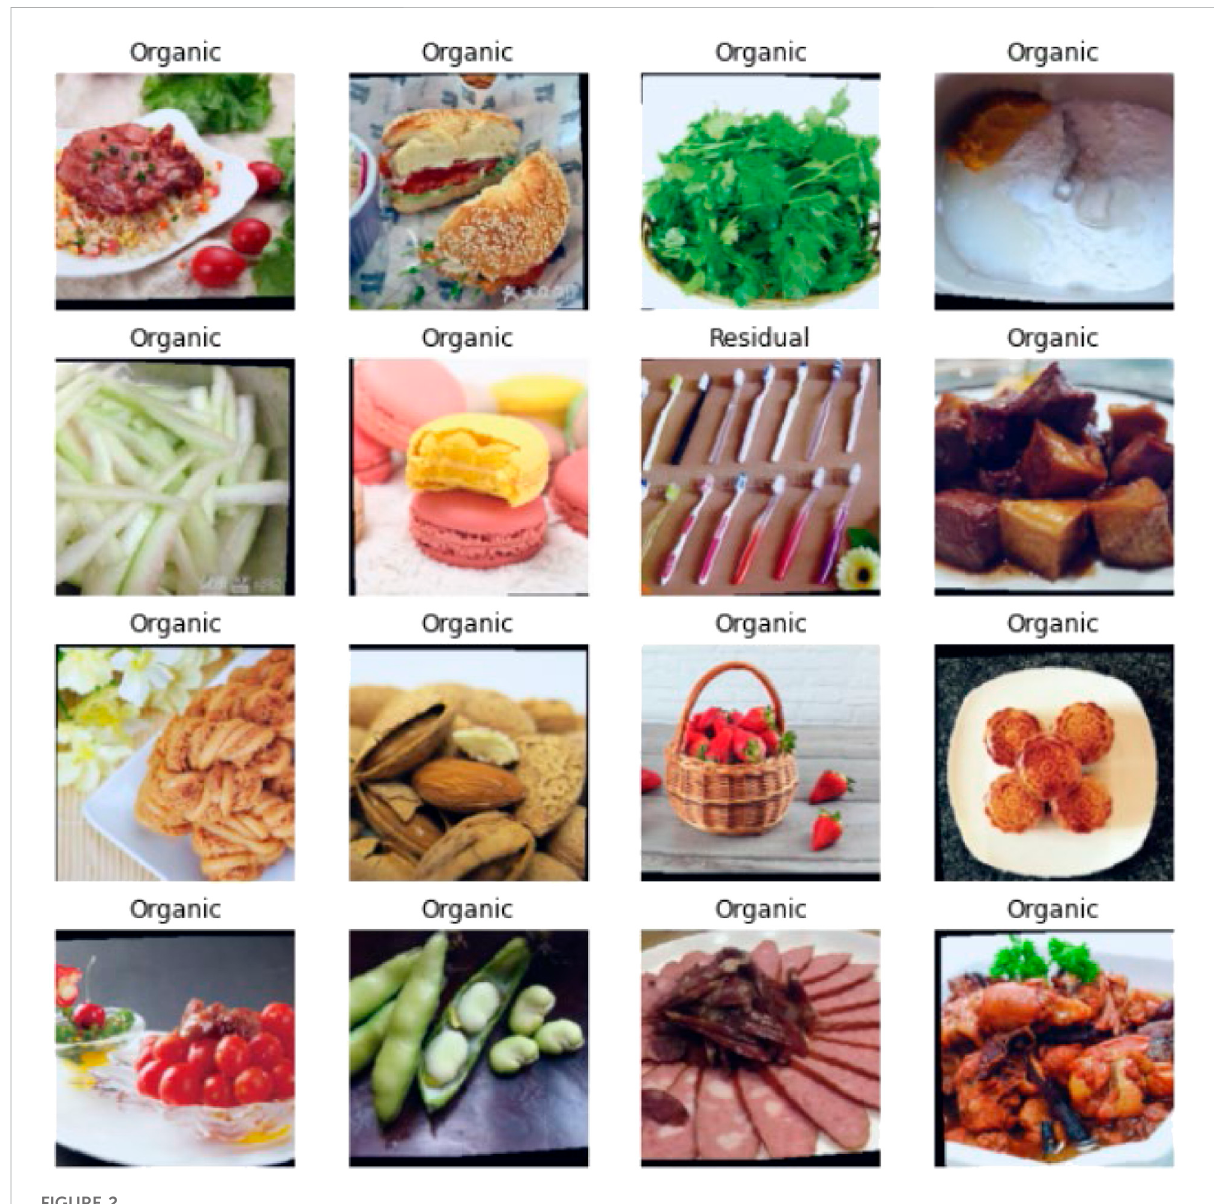
FIGURE 2 Example of organic waste and residual waste.